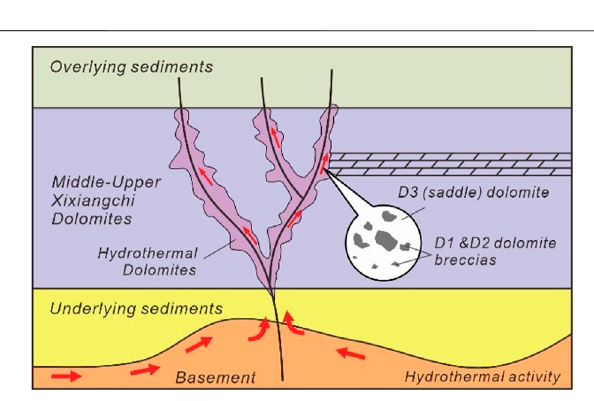
FIGURE 8 | Schematic interpretation of the fault/fracture-related hydrothermal alteration model (modi fi ed after Davis and Smith, 2006) for the investigated Middle – Upper Cambrian Xixiangchi dolomites in the study